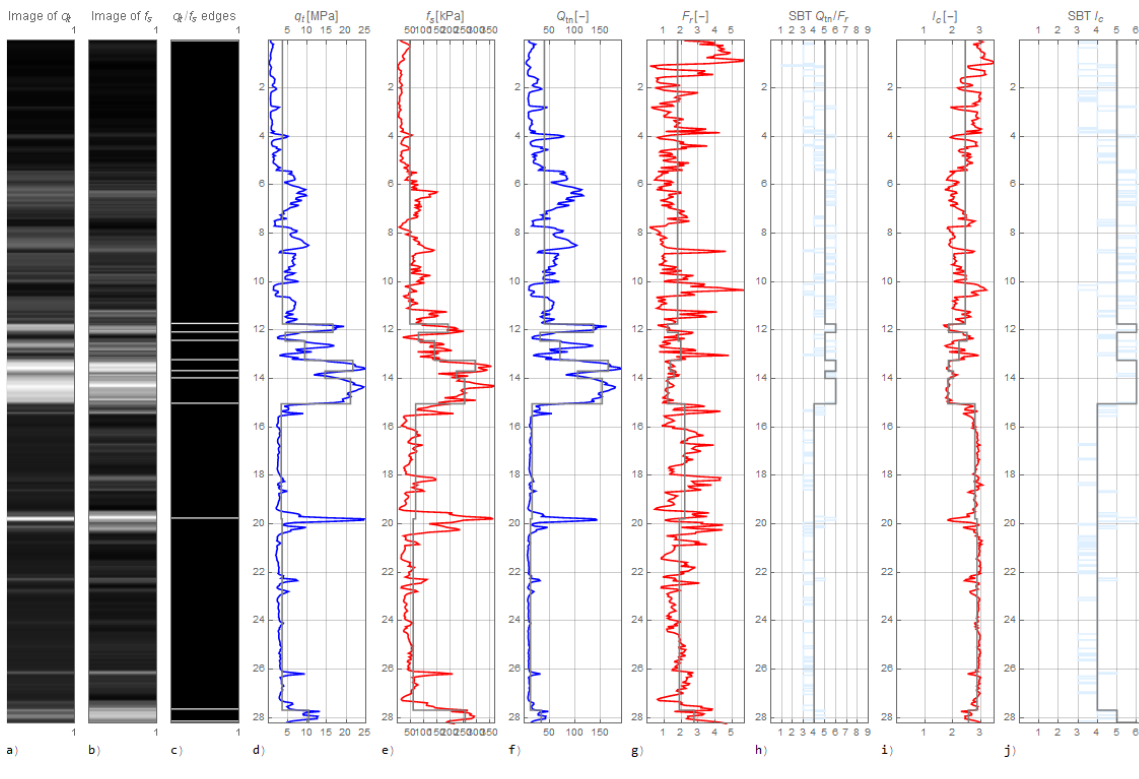
Figure 10: Results obtained with algorithm on testing dataset 3.